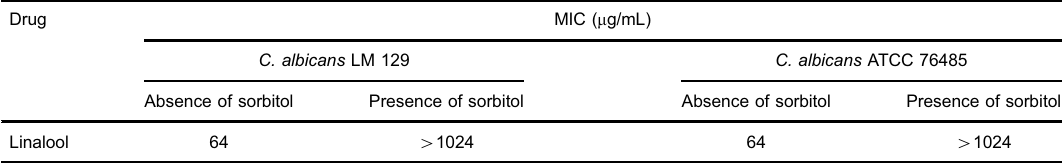
Table 2. Effect of linalool against C. albicans LM 129 and C. albicans ATCC 76485 in the absence and presence of 0.8 M